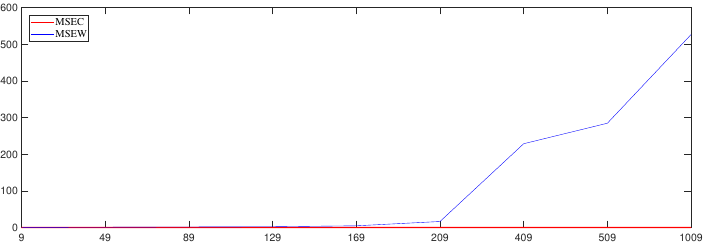
Figure 11. Folding line plot of the compared mean square error for a variance of 1.